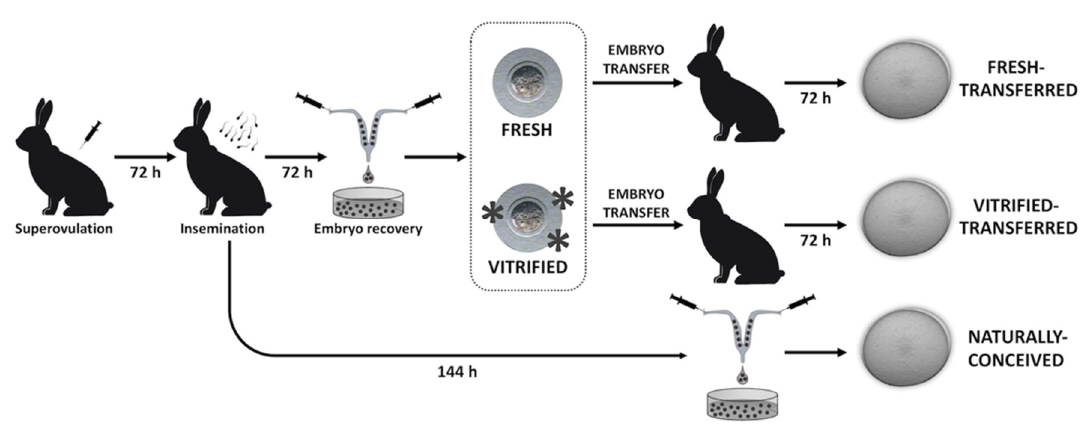
Figure 2. Experimental design. First of all, day-5 fresh and vitrified embryos were compared after 48 h of in vitro development under standard conditions. Their developmental potential and morphometric features were assessed. Moreover, day-6 preimplantation embryos obtained after fresh and vitrified embryo transfer were compared using naturally conceived embryos as reference. In this case, their recovery rates, morphometric features, and metabolomics profiles were analysed.